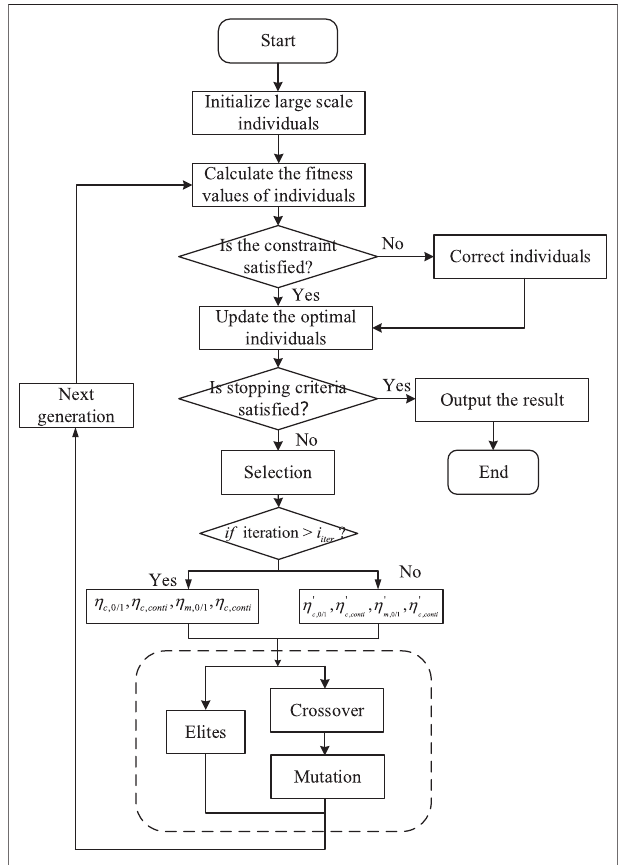
FIGURE 7 | The calculation procedure of improved